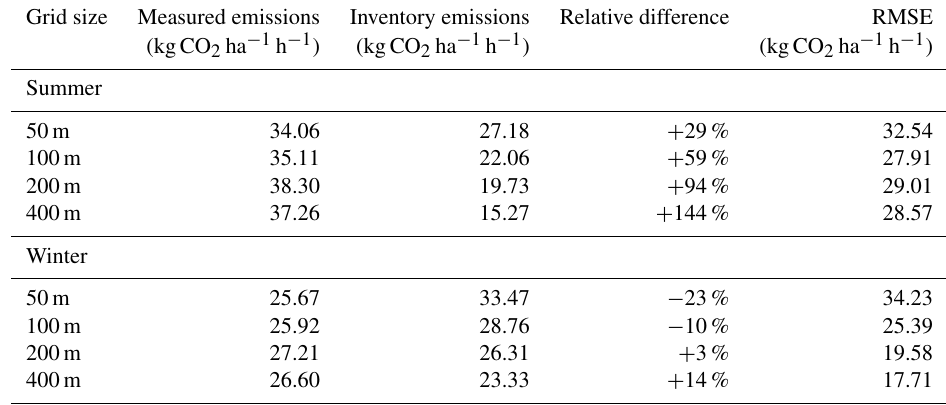
Table C2. Mean measured emissions versus mean inventory emissions for the winter and summer